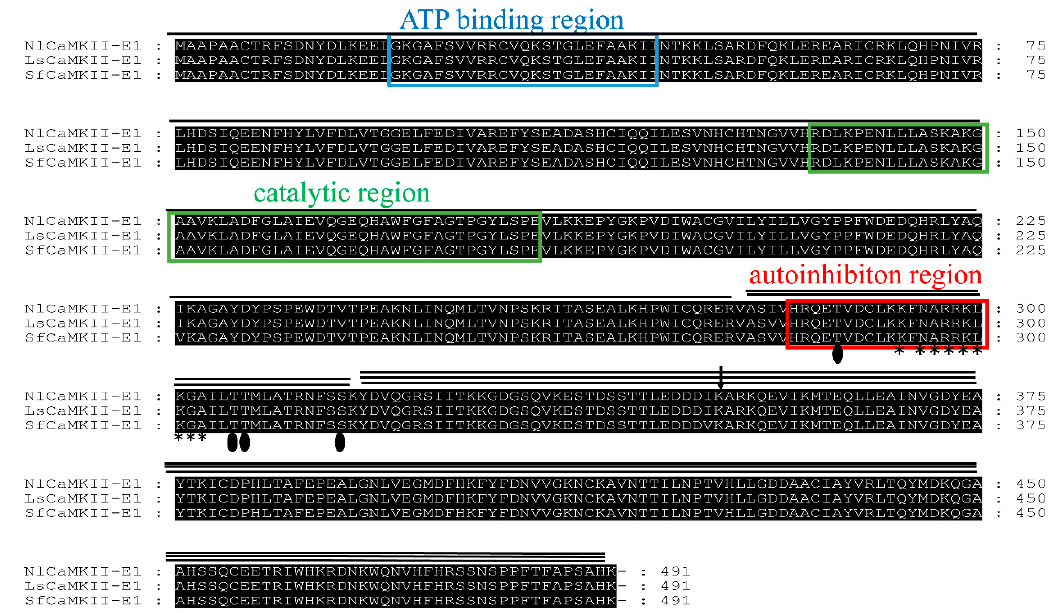
Figure 2. Amino acid sequence alignment of CaMKII-E1 proteins. The ClustalX (2.1) program was used for multiple sequence alignment. The catalytic, regulatory, and association domains are indicated by the single line, double line, and triple line, respectively. The blue and green boxes are the ATP-binding site and the catalytic region in the catalytic domain, respectively. The autoinhibition region in the regulatory domain is boxed in red. The asterisks and filled ovals show the CaM-binding region and the autophosphorylation sites within the regulatory region, respectively. The arrow represents the position at which various insert amino acids are inserted.